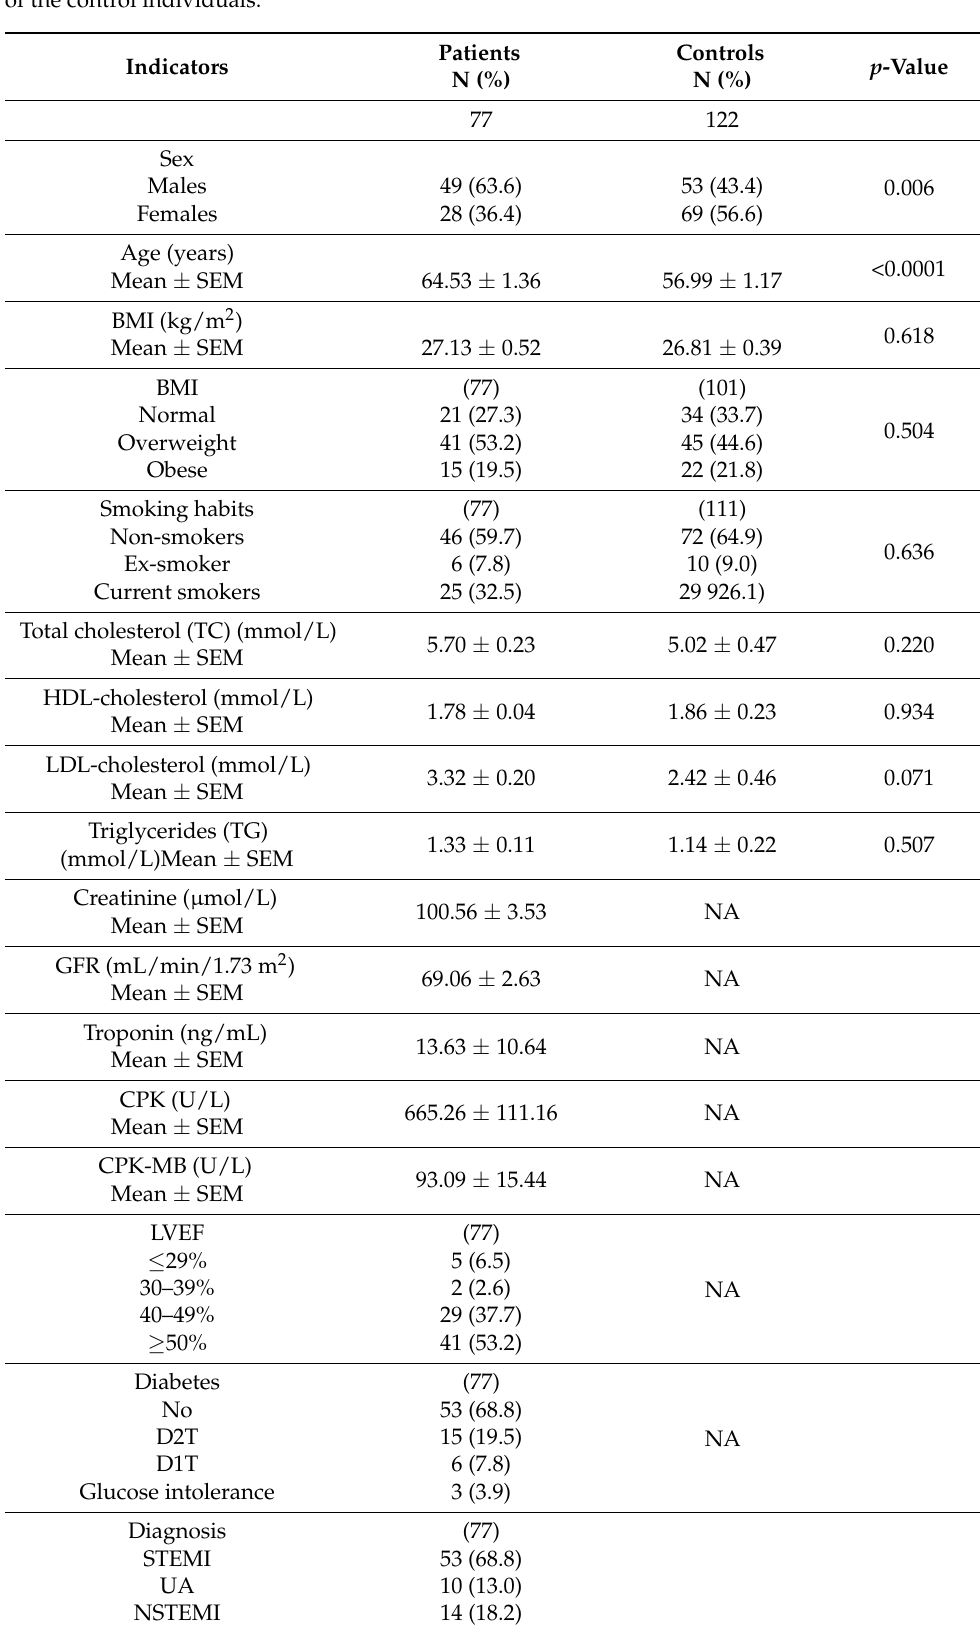
Table 1. Demographic and clinical characteristics of the patients with acute coronary syndrome and of the control